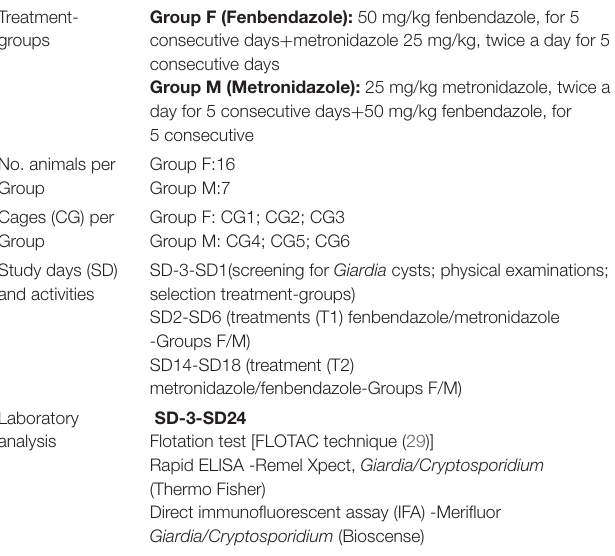
TABLE 1 | Study design. Treatment-